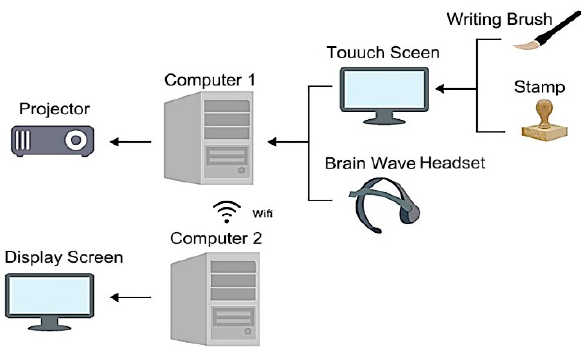
Figure 3. The architecture of the proposed system.